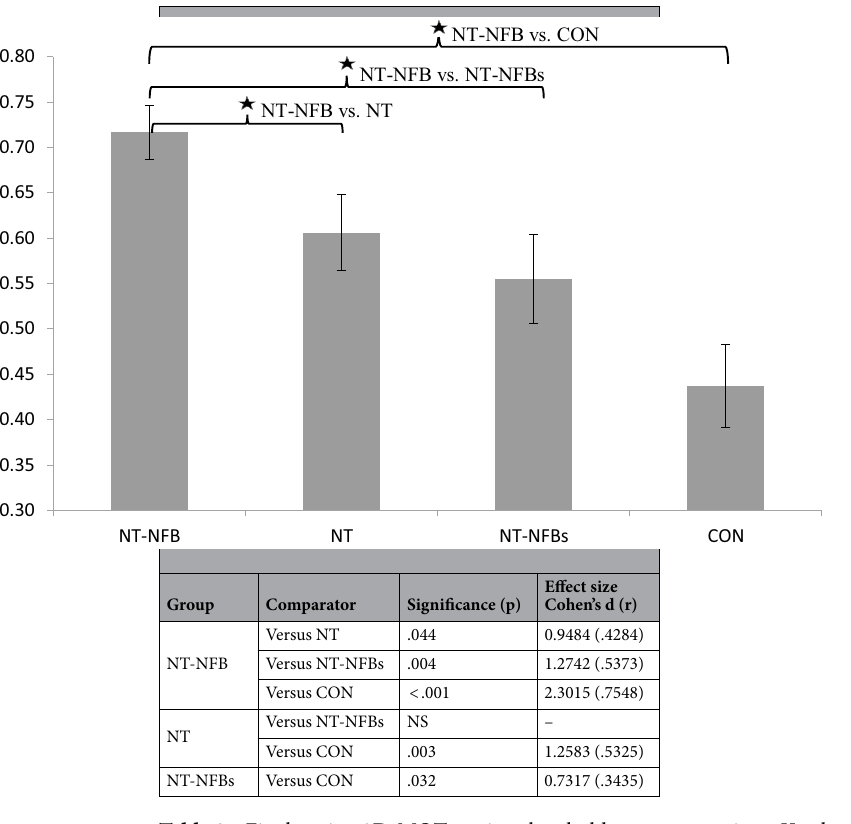
Table 2. Final testing 3D-MOT session threshold score comparison. Y values represent mean speed of the final testing session in metres per second. Cohen’s d = (M2 − M1)/SDpooled (M = mean, SD = standard